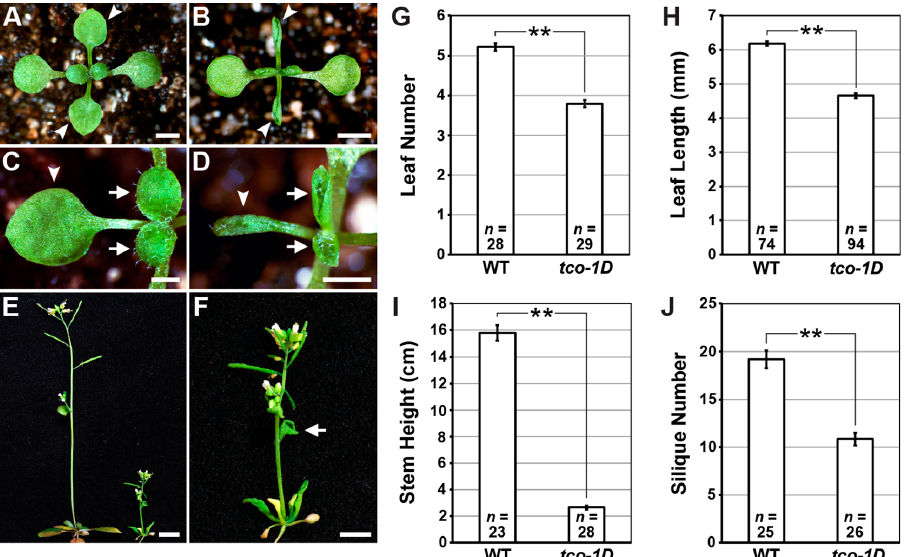
Figure 1. The activation-tagged mutant tco-1D has dominant, pleiotropic effects on Arabidopsis growth and development. ( A – D ) 14 days after germination (DAG) plants of wild type ( A , C ) and tco-1D ( B , D ). Arrowheads denote first pair of vegetative leaves, while arrows indicate the third and fourth leaves. Note strong upward curling displayed by tco-1D leaves. ( E ) 40 DAG plants of wild type (left) and tco-1D (right). ( F ) Higher magnification of tco-1D plant depicted in ( E ), with arrow denoting upward-curled cauline leaf. Bars: ( A , B ) 2 mm; ( C , D ) 1 mm; ( E ) 1 cm; ( F ) 5 mm. ( G – J ) Phenotypic comparisons between wild type (WT) and tco-1D . Number of vegetative leaves initiated prior to flowering ( G ), length of first vegetative leaves at 16 DAG ( H ), primary inflorescence stem height at 65 DAG ( I ), and number of siliques produced by the primary inflorescence stem ( J ) are shown. Data are represented as mean +/ − standard error (SE). Statistically significant differences are indicated (** p < 0.001; two-tailed t -test). Sample size ( n ) of each genotype is provided.